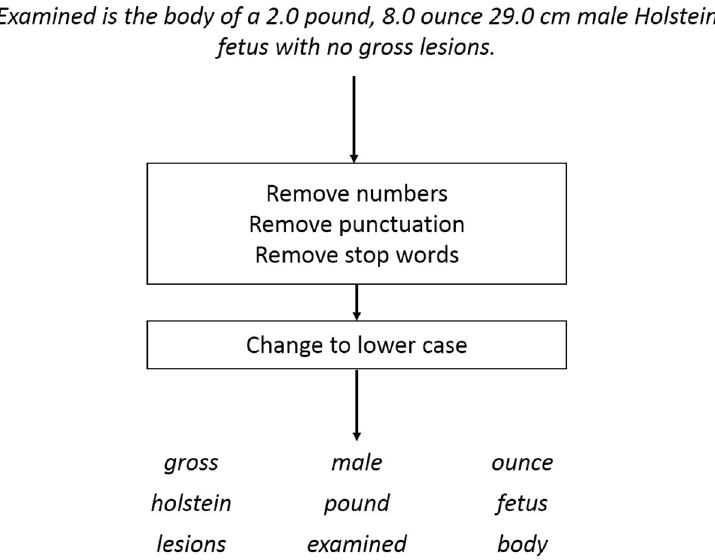
Fig 1. Tokenization. A document example was tokenized into words. Numbers and punctuation were removed. Stop words, common words in English (like “from”, “and”, and “of”) were removed. All characters were changed to lower case. After tokenization, the document was represented as a non-ordered collection of